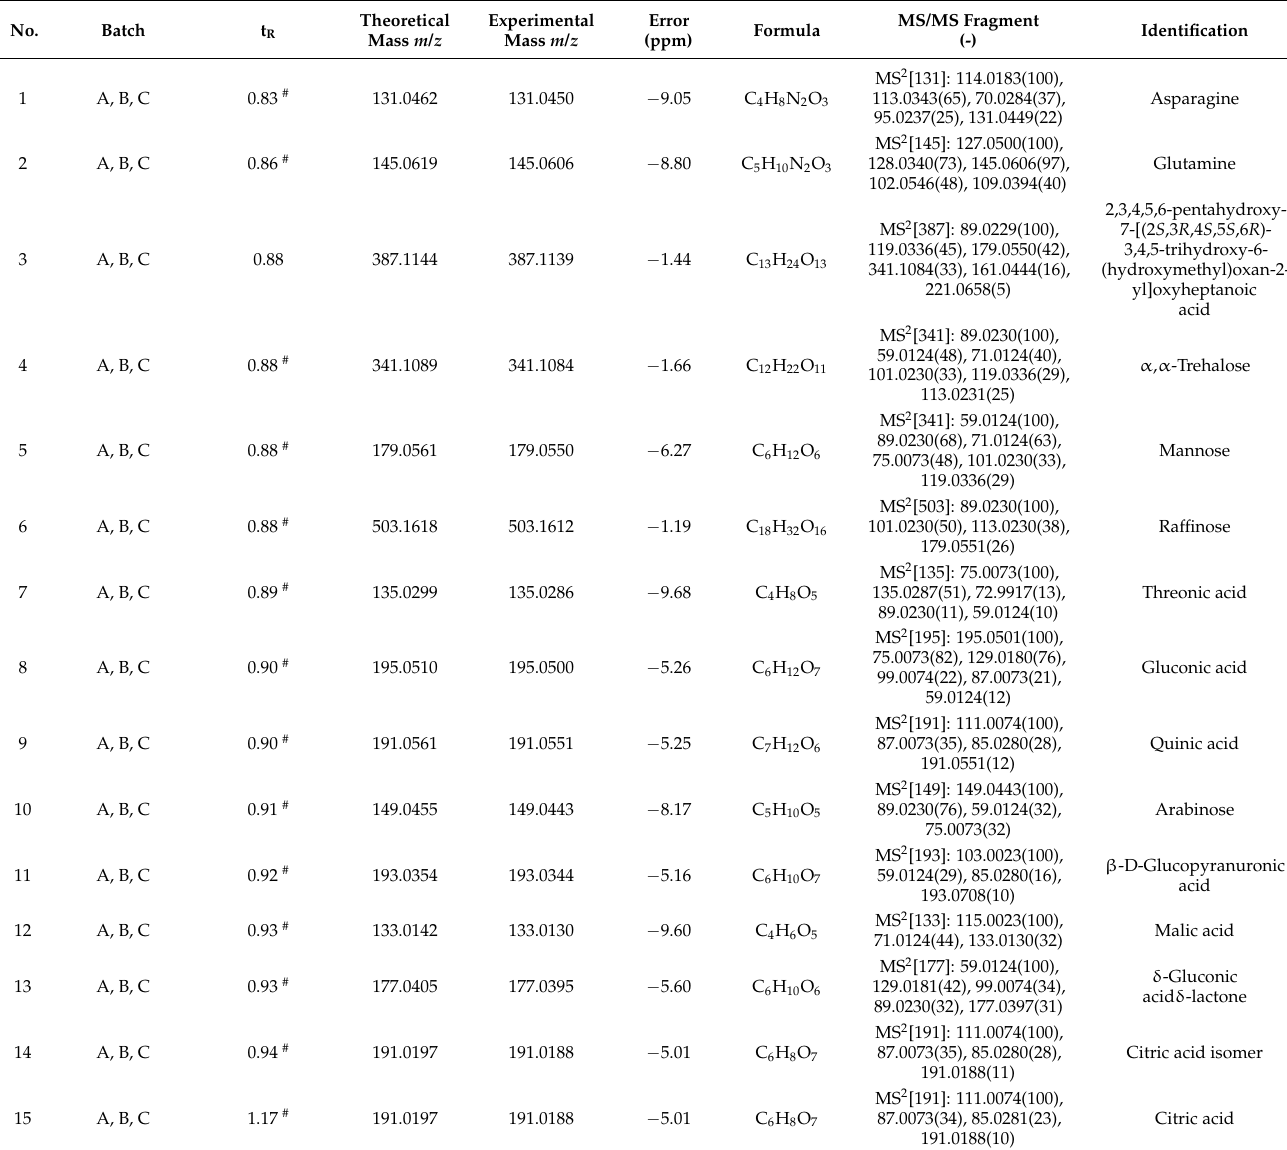
Table 1. Chromatographic and mass data of the components detected in Arnebiae Radix though UHPLC-Q-Exactive Orbitrap